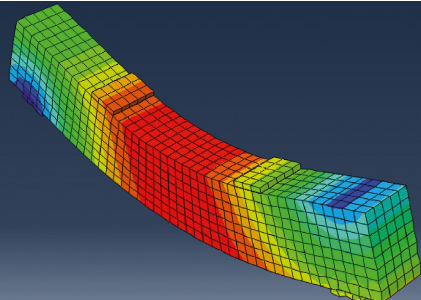
Figure 4: Modelling of the reinforcement steel and embedded truss.